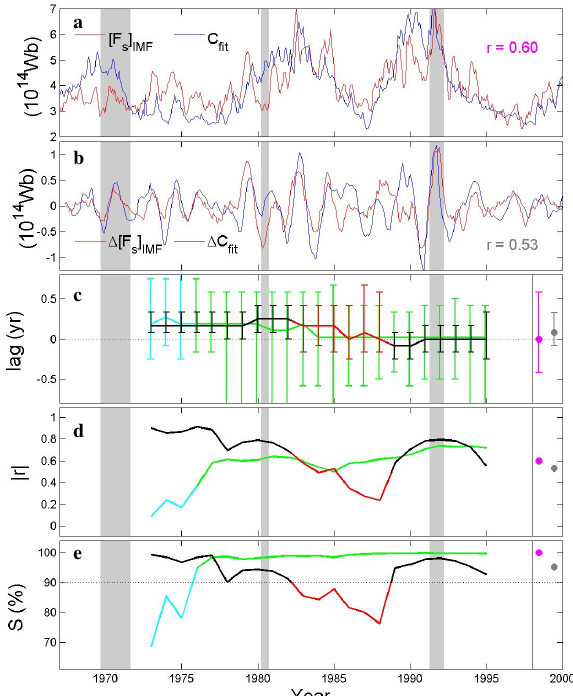
Fig. 9. The same as Fig. 7, for the correlation analysis of Huan- cayo/Hawaii neutron monitor ( > 13GV) counts H and the open so- lar flux deduced from the radial component of the IMF [ Fs ] IMF . Figure 9: The same as figure 7, for the correlation analysis of Huancayo/Hawaii neutron monitor The correlation of 1 [ Fs ] IMF and 1H is high ( r =0.61) so analysis (>13GV) counts H and the open solar flux deduced from the radial component of the IMF [Fs] IMF . The correlation of D [Fs] IMF and D H is high (r = 0.61) so analysis of D [Fs] IMF and D H are shown in of 1 [ Fs ] IMF and 1H are shown in (c), (d) and (e) (in addition to (c), (d) and (e) (in addition to that for the unfiltered data, [Fs] IMF and H , again shown in green and that for the unfiltered data, [ Fs ] IMF and H , again shown in green cyan): those in black have S ‡ 90% (the dotted line shown in the bottom panel), those in red have and cyan): those in black have S ≥ 90% (the dotted line shown in the S < 90%. bottom panel), those in red have S< 90%.